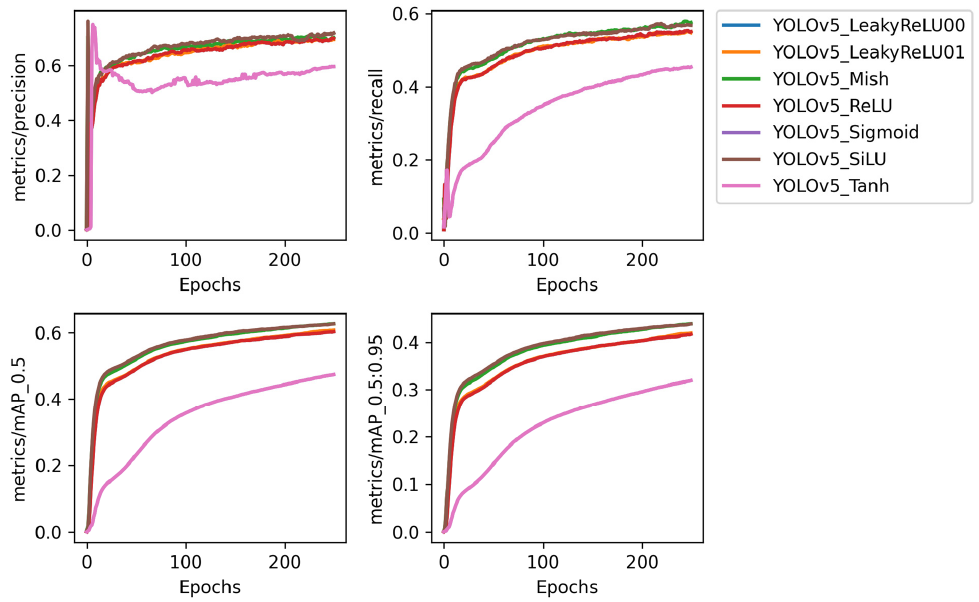
Figure 12. Evaluation prediction performance of the proposed VPP framework using different acti- vation functions of LeakyReLU, ReLU, Sigmoid, Mish, SiLU, and Tanh. From the empirical results, the selected activation functions of LeakyReLU, Sigmoid, Mish, and SiLU could similarly support the YOLO model to achieve better prediction per- formance than Tanh and ReLu. The worst evaluation performance is achieved using the Tanh activation function. To conclude, we choose to use the Mish default activation func- tion for conducting the rest of our experiments in this study. 4.1.3. Influence of Hyperparameter Optimization on Prediction Performance To further improve the prediction performance of YOLOv5x, an additional experi- mental study is conducted to investigate the most efficient training hyperparameter ini- tialization strategy. The YOLOv5x model is separately trained using three different hyper- parameters and initialization strategies, which are hyp.scratch-low (https://github.com/ultralyt- ics/yolov5/blob/2da2466168116a9fa81f4acab744dc9fe8f90cac/data/hyps/hyp.scratch- low.yaml (accessed on 23 June 2022)), hyp.scratch-med (https://github.com/ultralyt- ics/yolov5/blob/2da2466168116a9fa81f4acab744dc9fe8f90cac/data/hyps/hyp.scratch- med.yaml (accessed on 23 June 2022)), and hyp.scratch-high (https://github.com/ultralyt- ics/yolov5/blob/2da2466168116a9fa81f4acab744dc9fe8f90cac/data/hyps/hyp.scratch- high.yaml (accessed on 23 June 2022)). YOLOv5 has around 30 hyperparameters utilized for a variety of training configurations. These values are specified in *.yaml files located in the /data directory. Better initial predictions will provide better ultimate outcomes; thus, it is essential to establish these parameters correctly before evolving. The same train- ing settings and deep learning YOLOv5x structure are used for each instance of training. By conducting this study, the training and validation loss function values could be re- duced with the best evolved hyperparameters that can also support YOLOv5x to achieve better prediction performance results. Figures 13 and 14 depict the training evaluation results of YOLOv5x using various hyperparameters and initialization strategies.